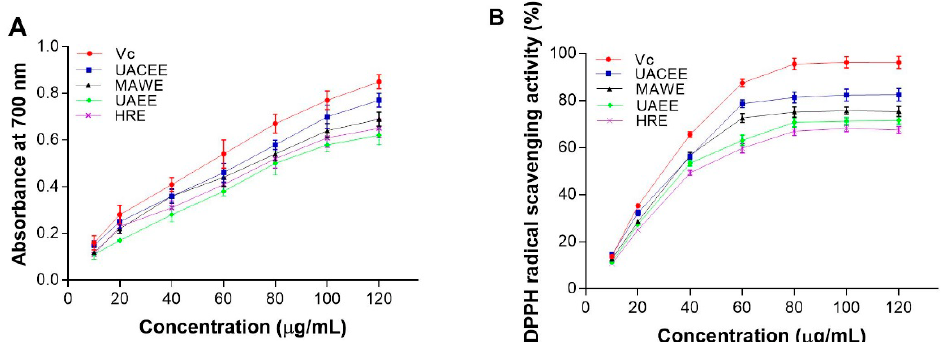
Fig. 5: Antioxidant activities of TPs from green tea obtained by UACEE, MAWE, UAEE and HRE extraction methods, respectively. reducing power (A); DPPH radical scavenging activity (B). Each value is the mean ± standard deviations of triplicate measurements. UACEE, ultrasound-assisted compound enzymatic extraction; MAWE, microwave-assisted water extraction; UAEE, ultrasonic-assisted ethanol extrac- tion; HRE, heat reflux